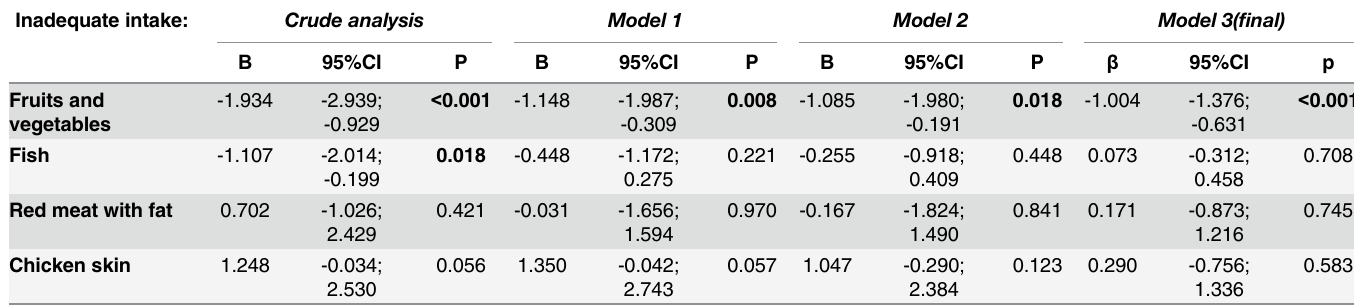
Table 2. Relationship between indicators of unhealthy food habits (inadequate food intake) and cognition in women. EpiFloripa Elderly , 2013/2014.